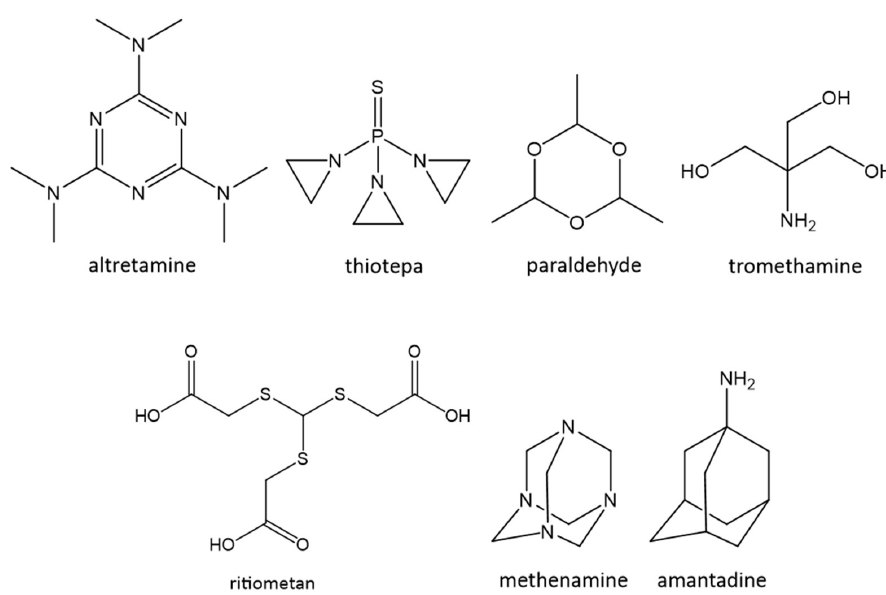
Figure 3. Structural representation of the currently marketed